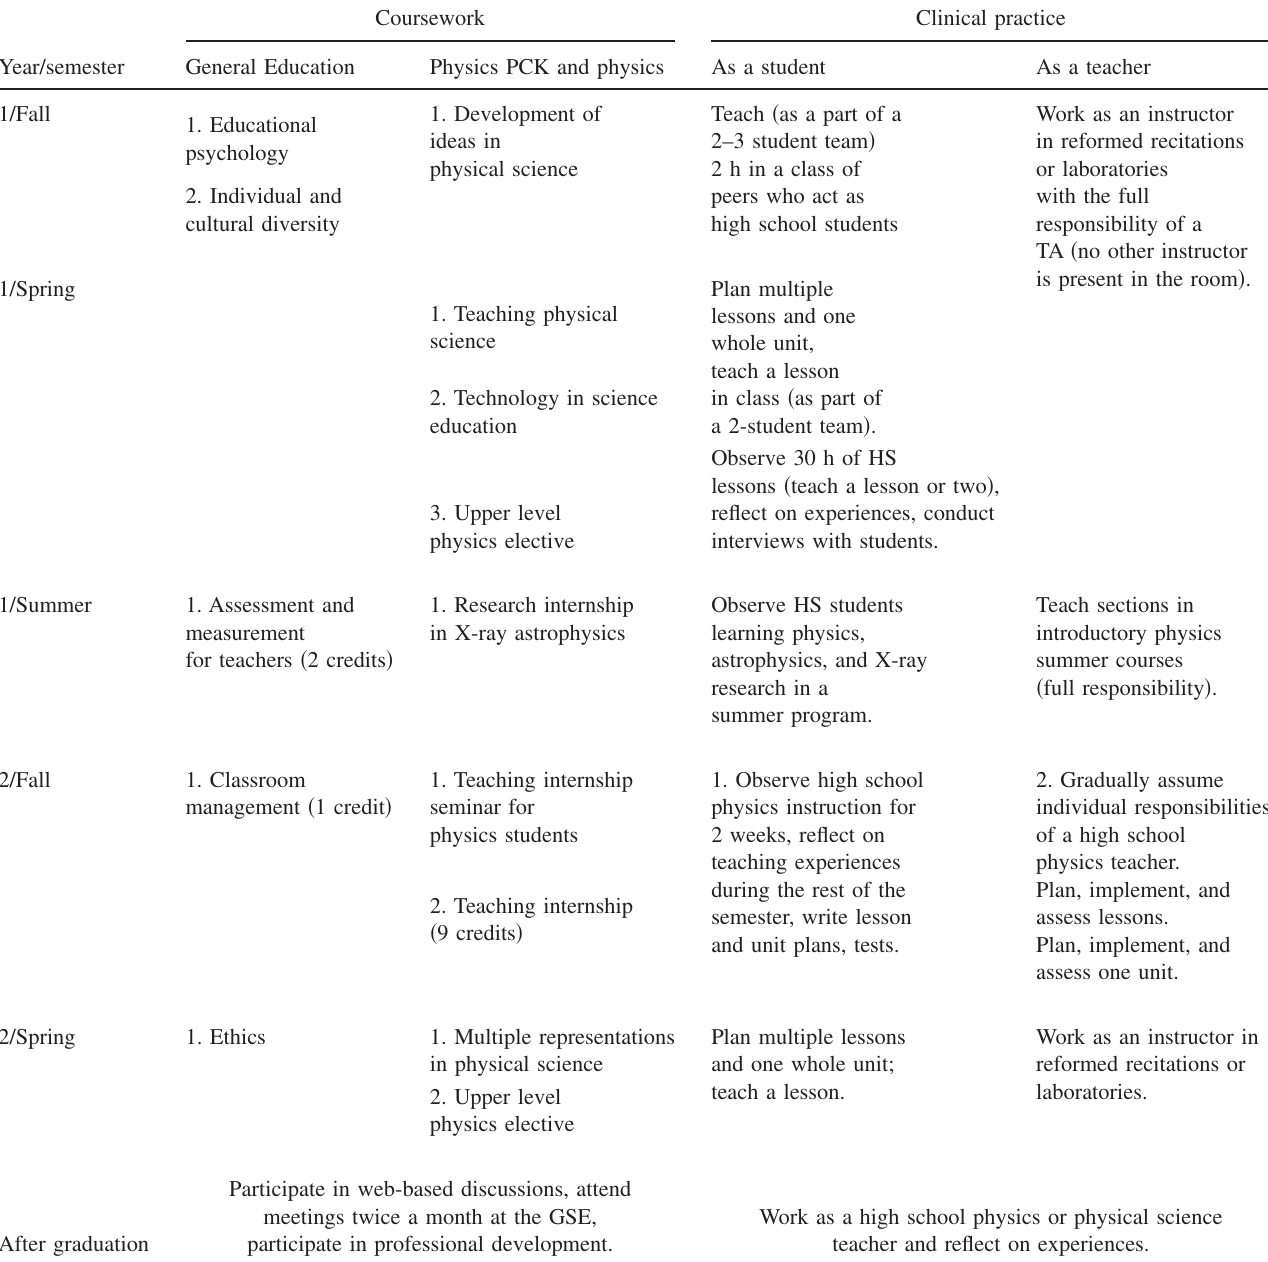
TABLE III. Coursework and clinical